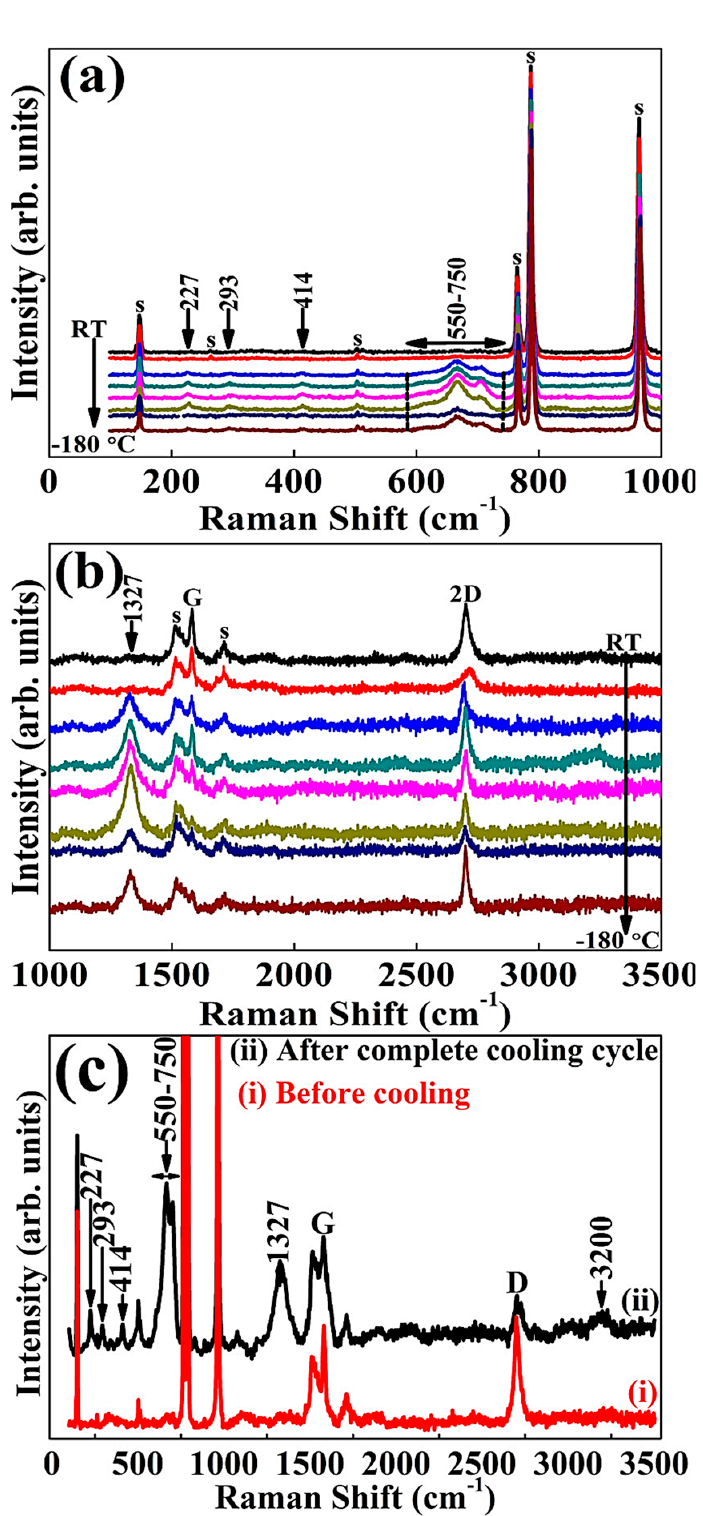
Figure 2. ( a ) Temperature-dependent Raman spectra recorded from room temperature to − 180 °C in Raman frequency range of 1000–3500 cm − 1 . ( b ) Temperature-dependent Raman spectra were recorded from room temperature to − 180 °C in the Raman frequency range of 100–1000 cm − 1 . ( c ) Raman spectra of epitaxial graphene were taken at room temperature before and after the cooling cycle.